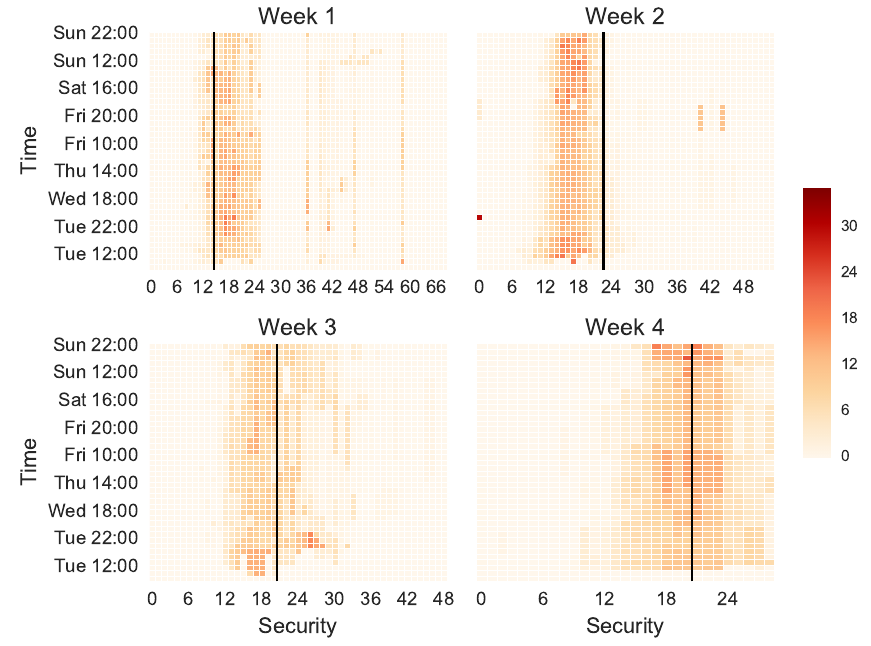
Figure 3: Experiment 2: The evolution of security prices over time. Within a trading period (one week) the prices are generally stable; price levels are established rather early in the week and remain relatively constant. In week one, the distribution of prices is multi-peaked, with four securities emerging as favorites. The tendency disappears in week 2, which has a single-peaked distribution and further the distribution becomes wider and less-peaked, indicating larger uncertainty about the success of each